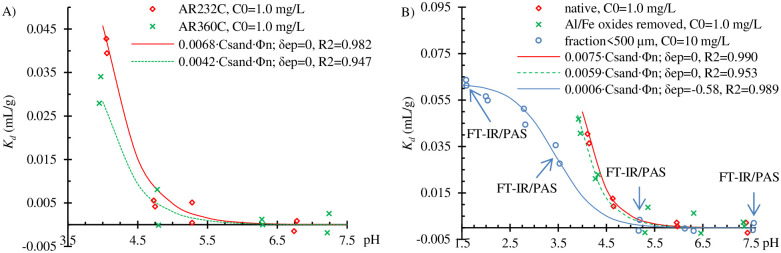
Observed Kd values and results of modeling of the pH-dependent adsorption in soils with no organic matter.(A) AR232C and AR360C, (B) AR774C, AR774C with removed Al and Fe oxides [20], as well as in AR774C fraction < 500 μm with ten times higher initial bentazone concentration.